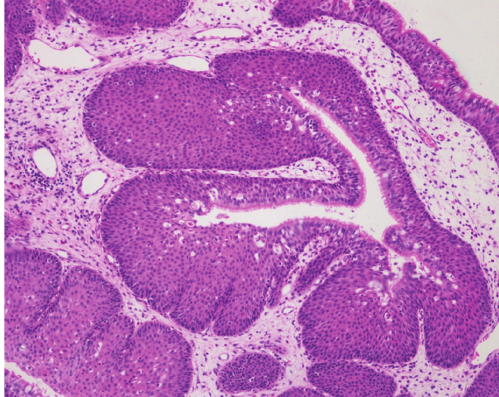
Figure 3: Papillary hyperplasia of the transitional epithelium. (Hematoxylin-eosin stain; original magnification ×